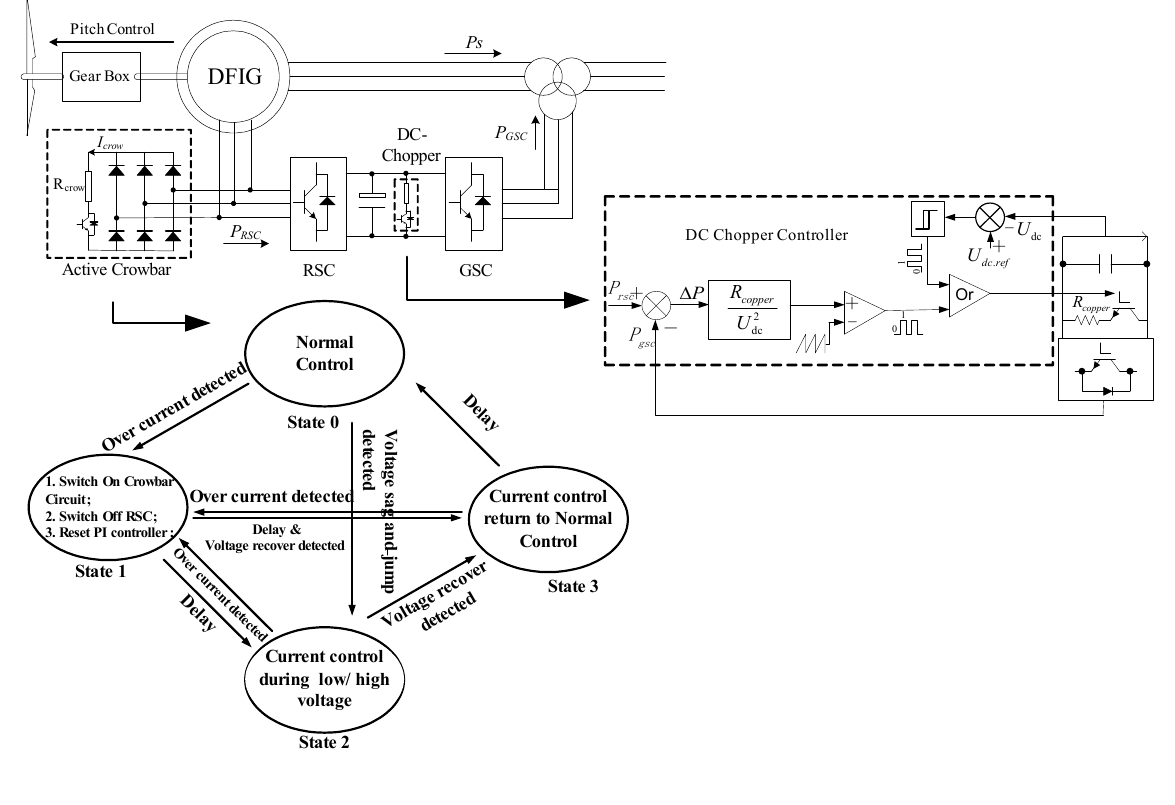
Figure 6. DFIG WTG model with protection